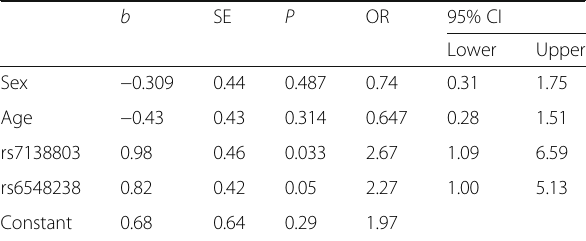
Table 7 Multivariant logistic analysis of the association between genetic loci with diabetes risk b SE P OR 95% CI Lower